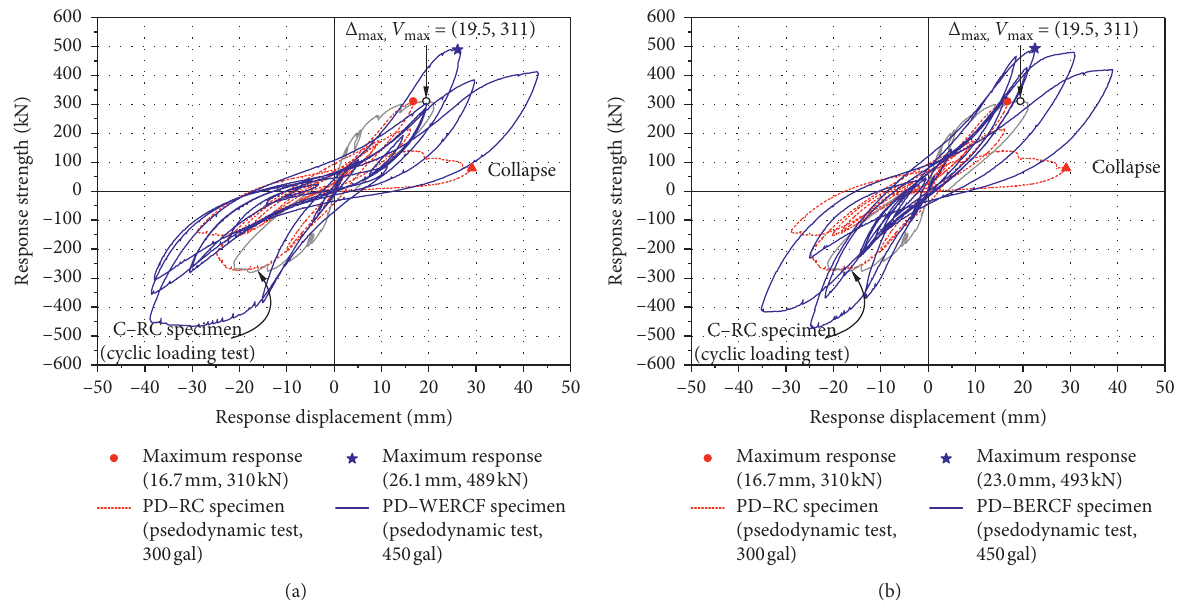
Figure 14: Lateral response load-displacement relationships for specimens strengthened with the ESRCF system during pseudodynamic testing at 450gal. (a) PD-WERCF; (b)